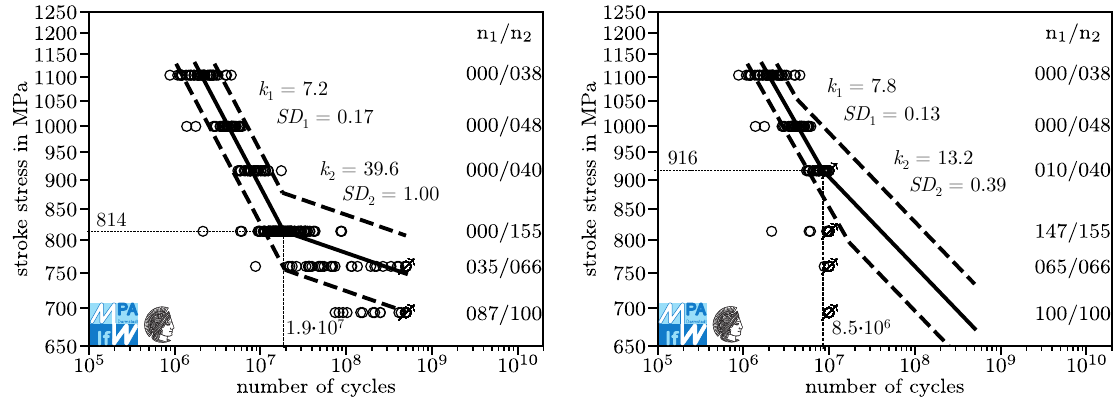
Figure 5. Fatigue curves with 10, 50, and 90% survival probability, generated from the original dataset ( left ) and from a dataset generated by artificial censoring at 10 7 cycles ( right ), data from [3]. Both curves look nearly the same up until 8.5 · 10 6 cycles. At over 8.5 · 10 6 cycles, the fatigue